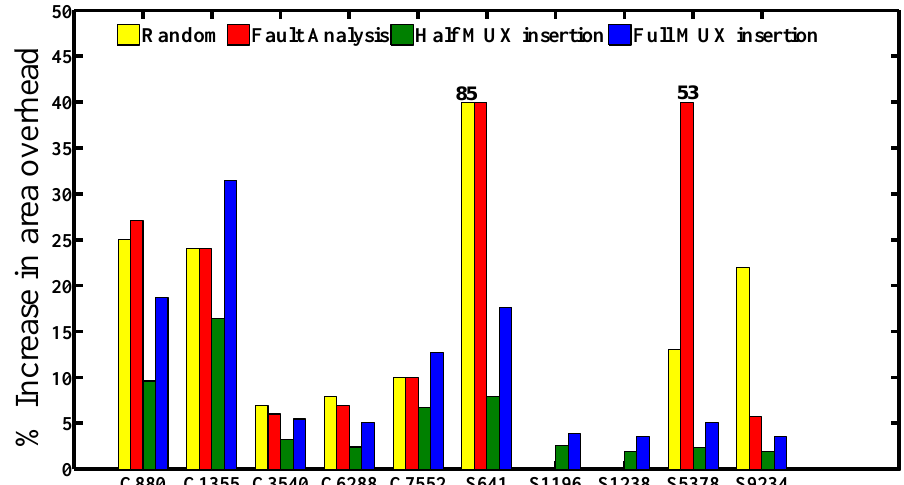
Figure 10. Comparing the area overhead of random, fault analysis and full/half MUX insertions for logic encryption.